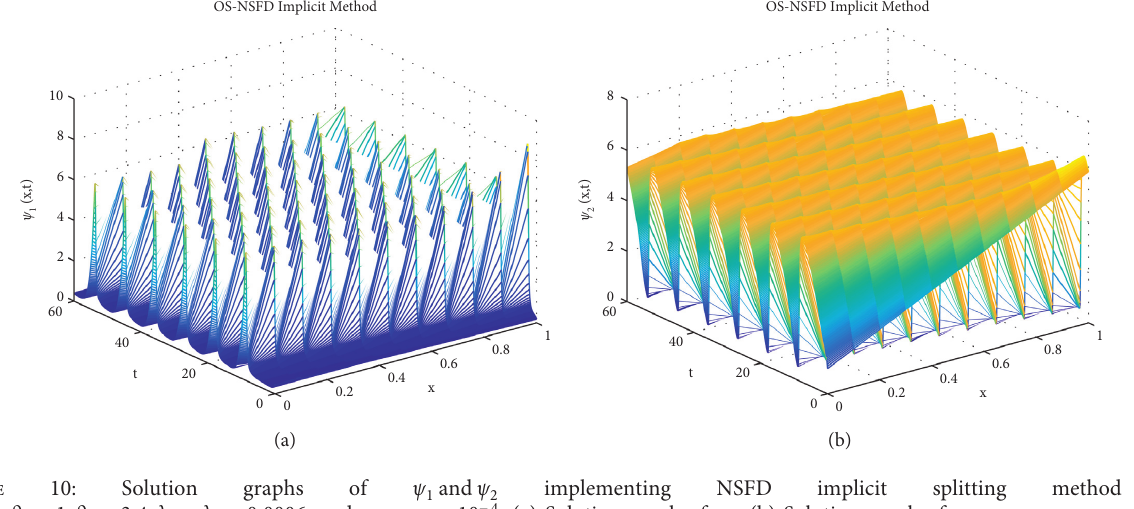
10: Solution graphs of ψ